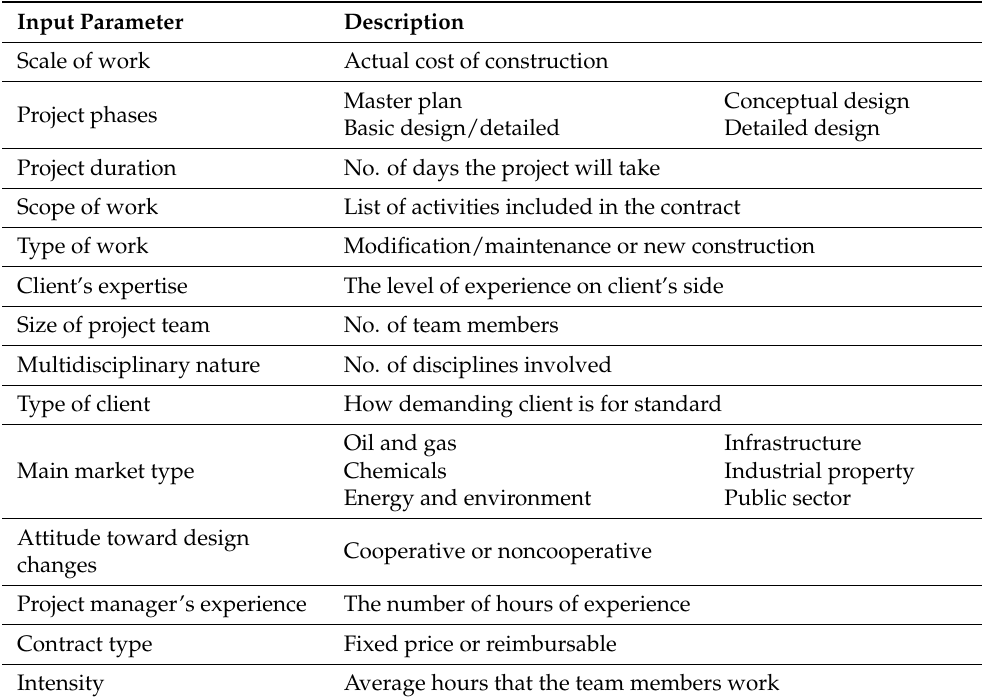
Table 3. Some input parameters for cost